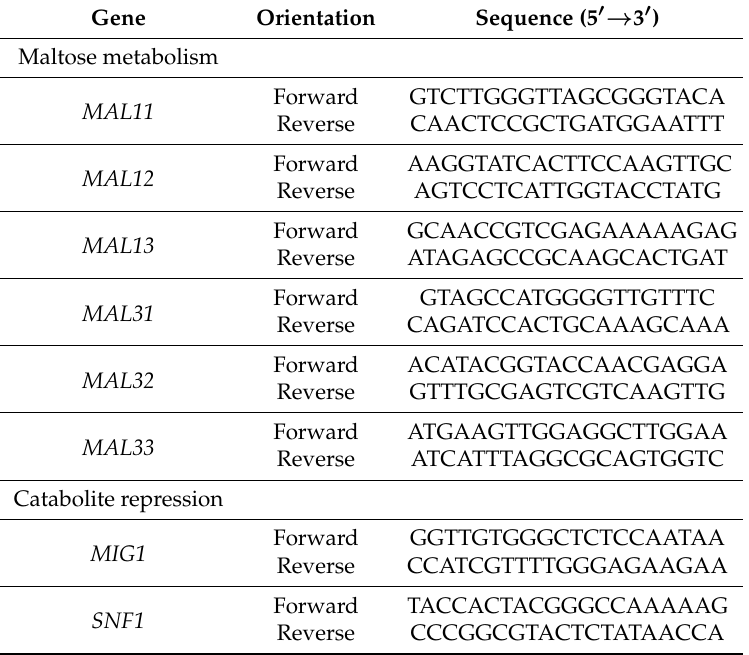
Table 1. Oligonucleotide primer sequences used in this